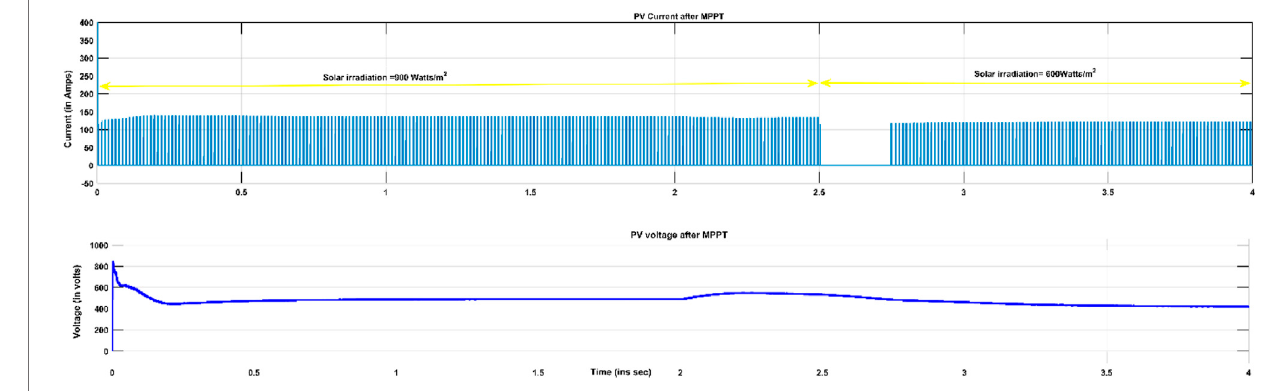
FIGURE 5 | PV current and voltage after MPPT.